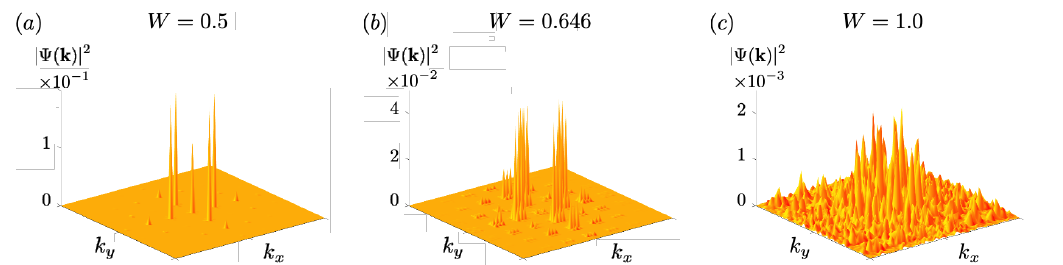
Figure 8: Wave-functions : The momentum space probability distribution, | Ψ ( k ) | 2 , plotted as the system goes through the magic-angle delocalization transition in mo- mentum space. The system size L = 89 = F is used. The main peak at the M -point (center of the plot) and several satellite peaks are seen prior to the transition [ (a) ] ; the peaks in (a) become strongly hybridized with states in the vicinity and starts to delocalize in momentum space [ (b) ] ; the system further delocalizes and nears the fully delocalized state [ (c) ] in momentum space. Note the drastic difference in the y